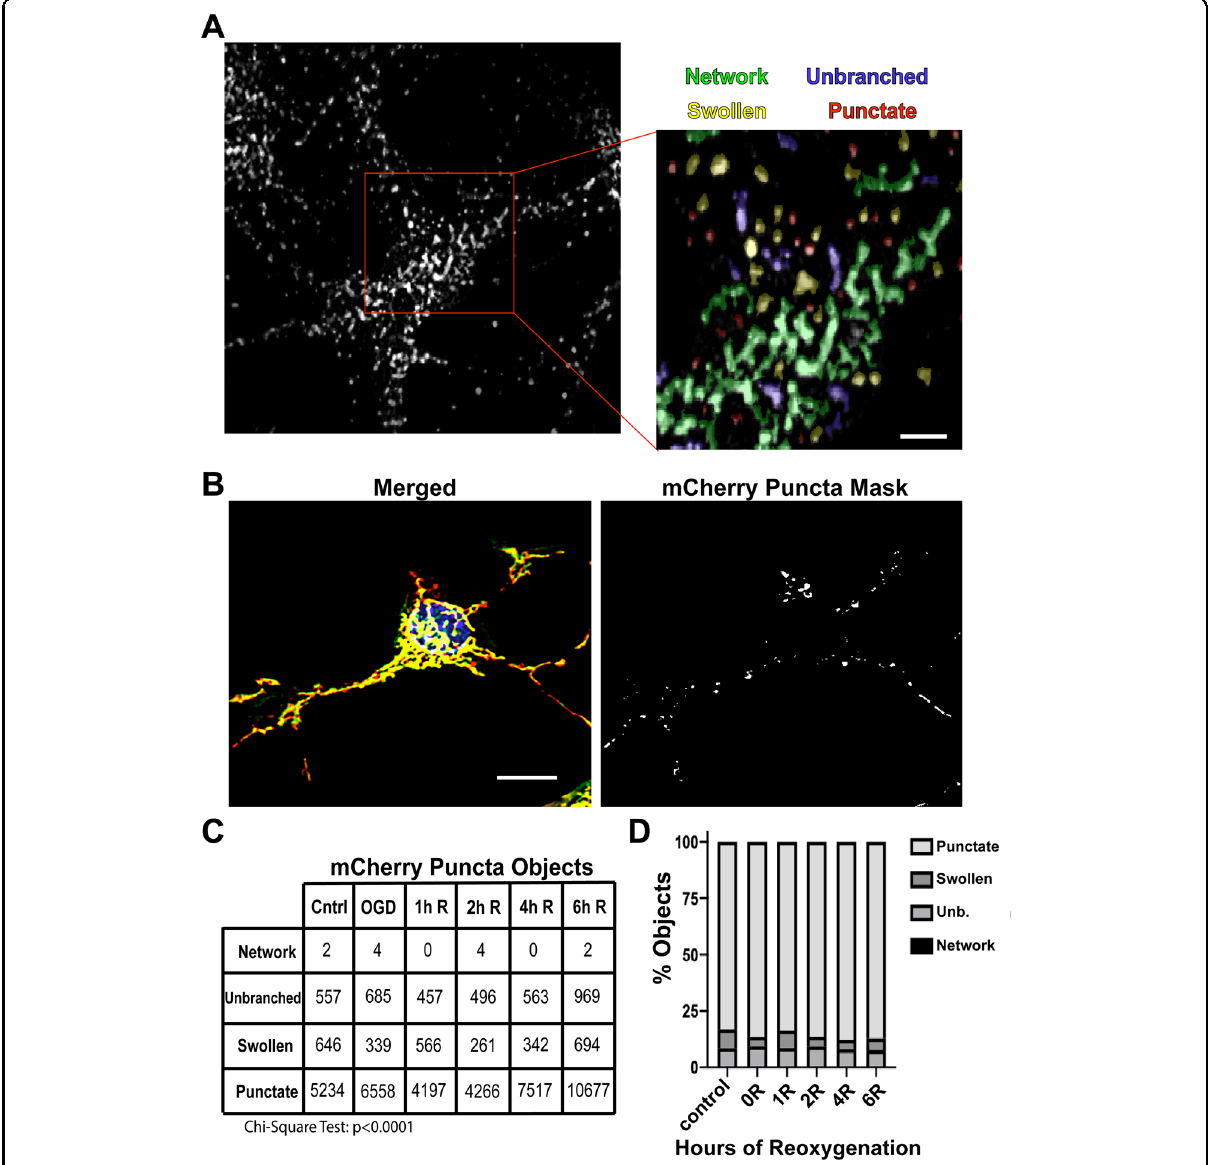
Fig. 3 Mitochondria morphology classi fi cation of mCherry puncta. A Mitochondrial morphology was classi fi ed using a machine learning-based classi fi cation system. Mitochondria were classi fi ed into four different morphologies consisting of: networks (green), unbranched (blue), swollen (yellow), and punctate (red). Scale bar = 5 µm. B mCherry puncta were segmented from images of MitoQC neurons and analyzed using our mitochondrial morphology classi fi cation system. C Total mCherry puncta counts throughout reoxygenation (R). D Stacked bar graphs representing percent red puncta throughout R. mCherry puncta: n = 4 biological replicates, 44,536 objects. Scale bar = 10